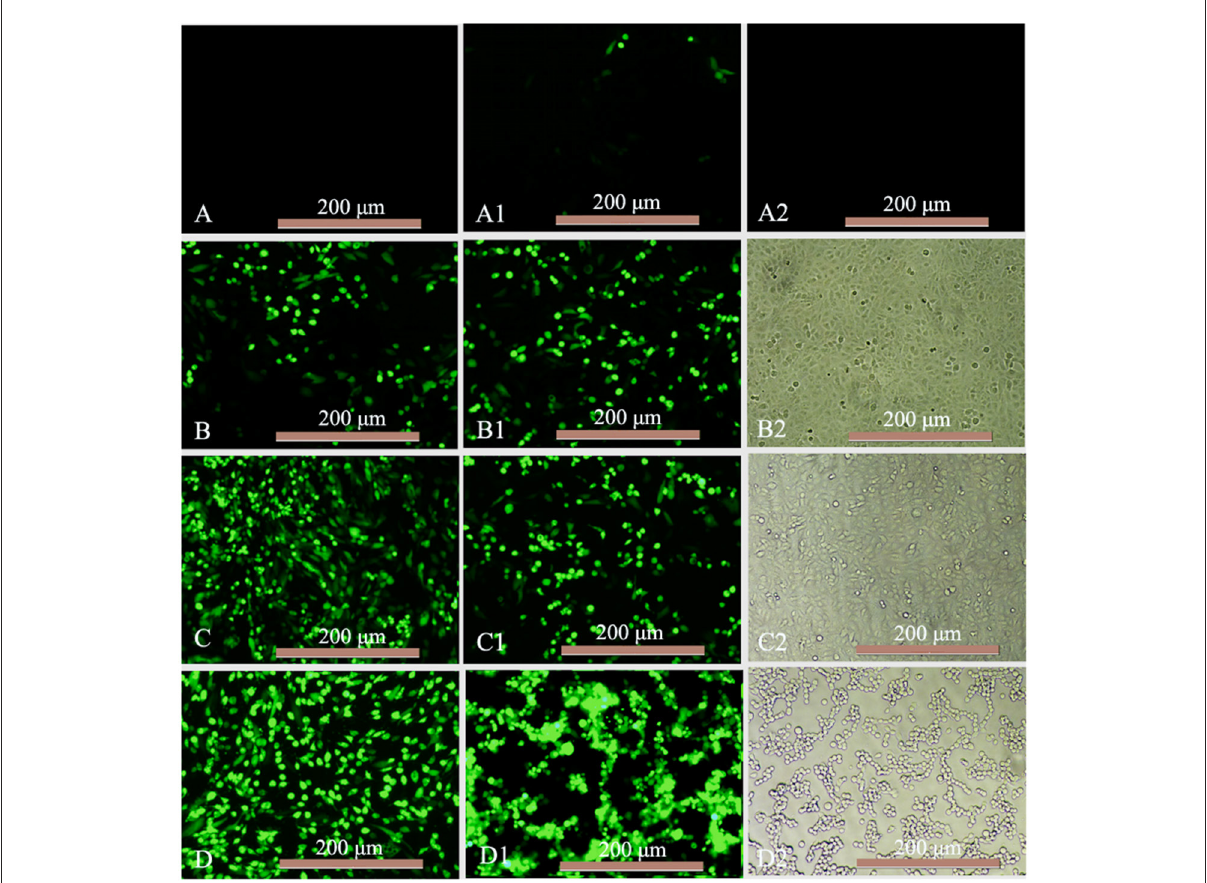
FIGURE5 Antiviral activity of MiIFN- α against VSV-GFP in F81 cells. (A–D) Changes in the green fluorescence intensity indicating the antiviral activity of the canine IFN- α standards of 488.28 IU/mL (4 6 -fold), 122.07 IU/mL (4 7 -fold), 30.52 IU/mL (4 7 -fold), and 7.63 IU/mL (4 7 -fold). (A1) MiIFN- α 0.36 ng/mL(4 6 -fold). (B1) MiIFN- α 0.091 ng/mL(4 7 -fold). (C1,C2) MiIFN- α 0.023ng/mL (47-fold). (A2,B2) Uninfected cells. (D1,D2) Virus